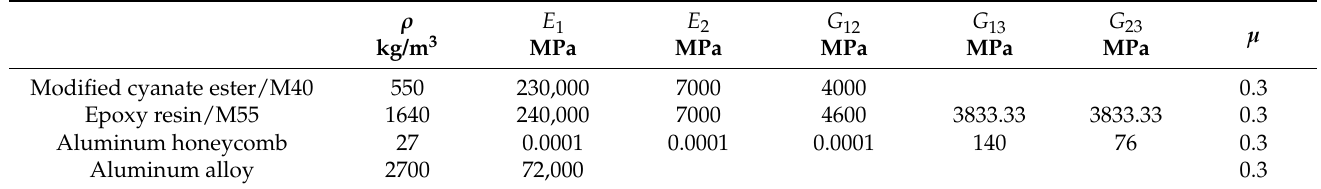
Table 1. Material mechanical